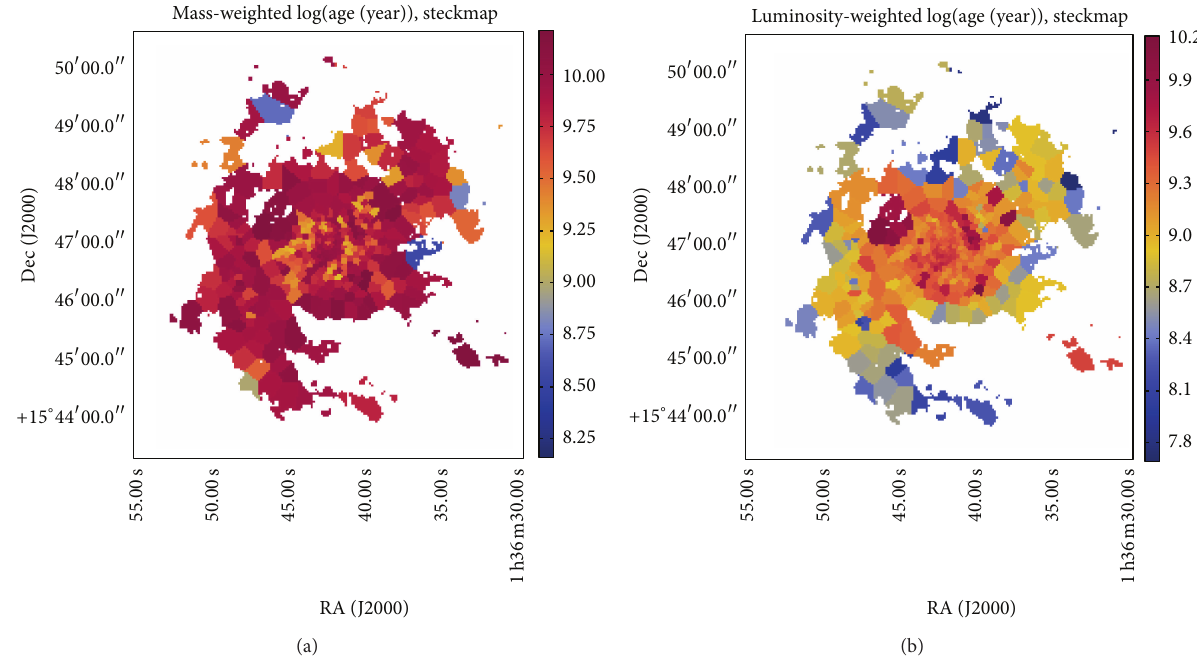
Figure 5: Mean age 2-D maps weighted by the mass (a) and by the light (b) of the stars. The different regions correspond to a Voronoi- tessellation binning scheme performed to the IFS mosaic of NGC 628. Figure adapted from S´anchez-Bl´azquez et al.